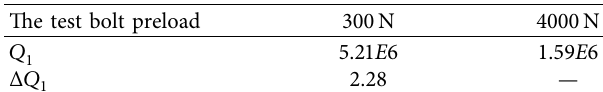
— Table 7: Q and Δ Q of the connection structure with 6 bolts under 1 1 1000N impact load with standard preload of 5000N and loose bolt — Table 8: Q 1 and Δ Q 1 under different loose bolt preload of the connection structure with 6 bolts under 1500N impact load with standard preload of 5000N.